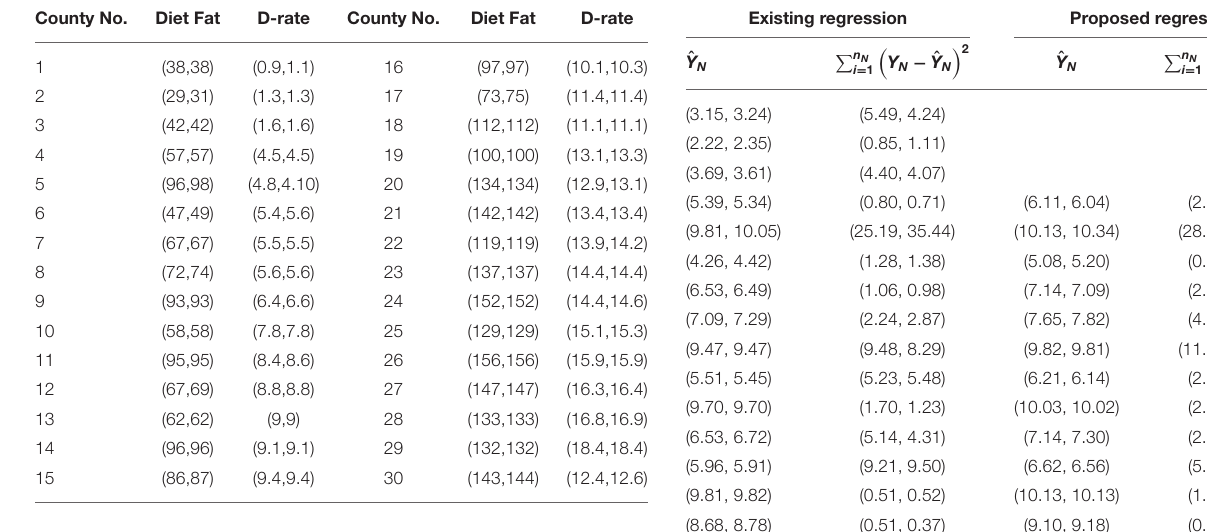
TABLE 2 | Trimmed Prostate cancer death rate of 30 countries. County No.